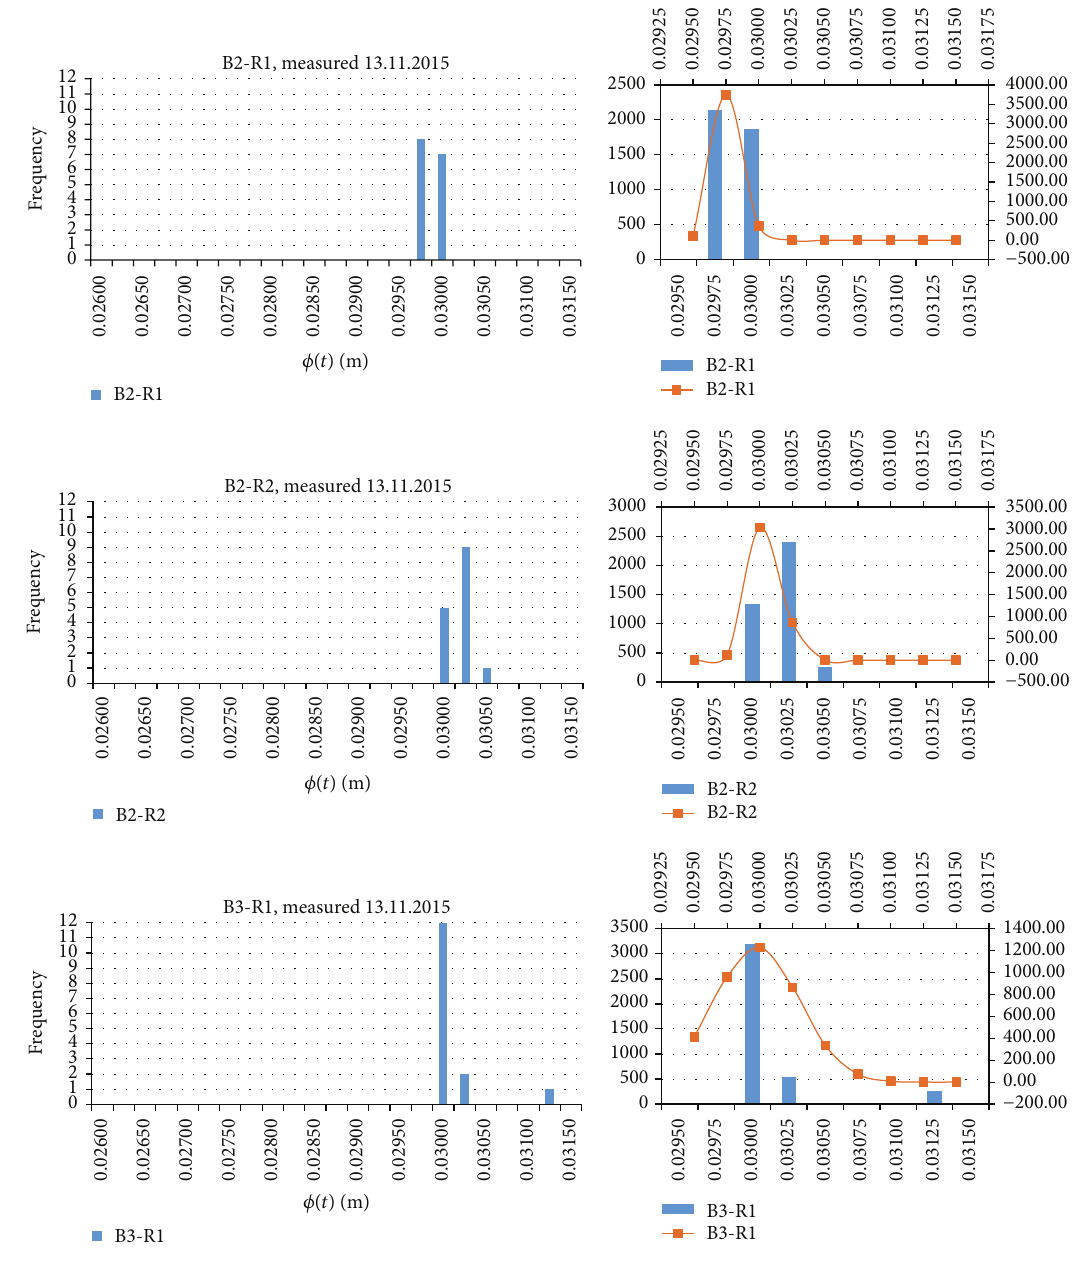
Figure 9: Results from measurements of initial bars’ diameters: B2-R1, B2-R2, and B3-R1.